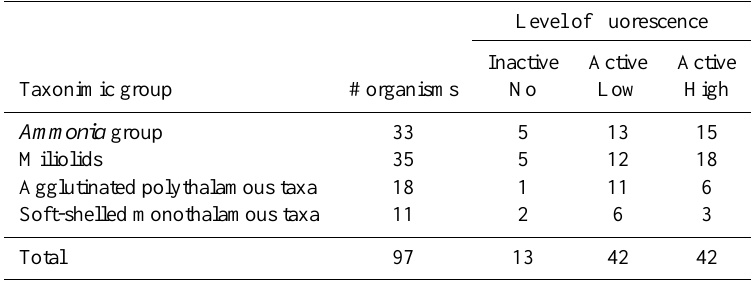
Table 3. Classification of fluorescence emission after FISH hybridization performed on organisms belonging to different taxonomic groups (already shown in Tables 1 and 2). No=no fluorescence emission; low=weak fluorescence emission; high=strong fluorescence emission. Fluorescence intensity was used as an index of metabolic activity (inactive vs. active). See text for